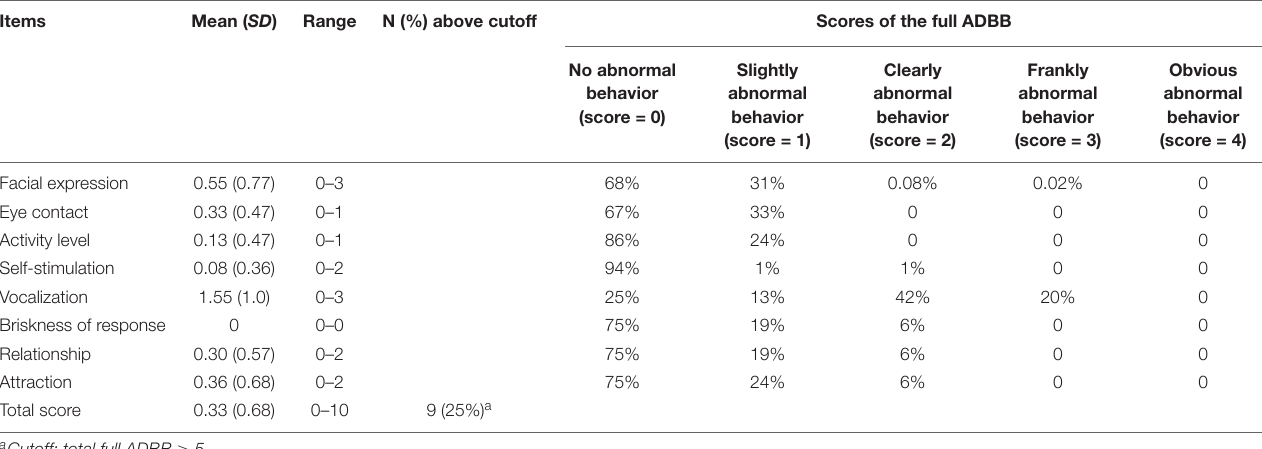
TABLE 6 | Mean (SD) and range of the Full Alarm Distress Baby (ADBB) scale scores ( n = 36), % of children in each response category and number (%) of children scoring above cut off for social withdrawal.